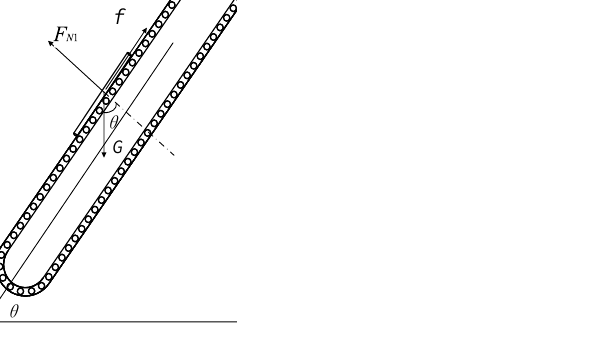
Figure 6. Mechanical analysis of crushed sweet potato vines on conveyer belt.